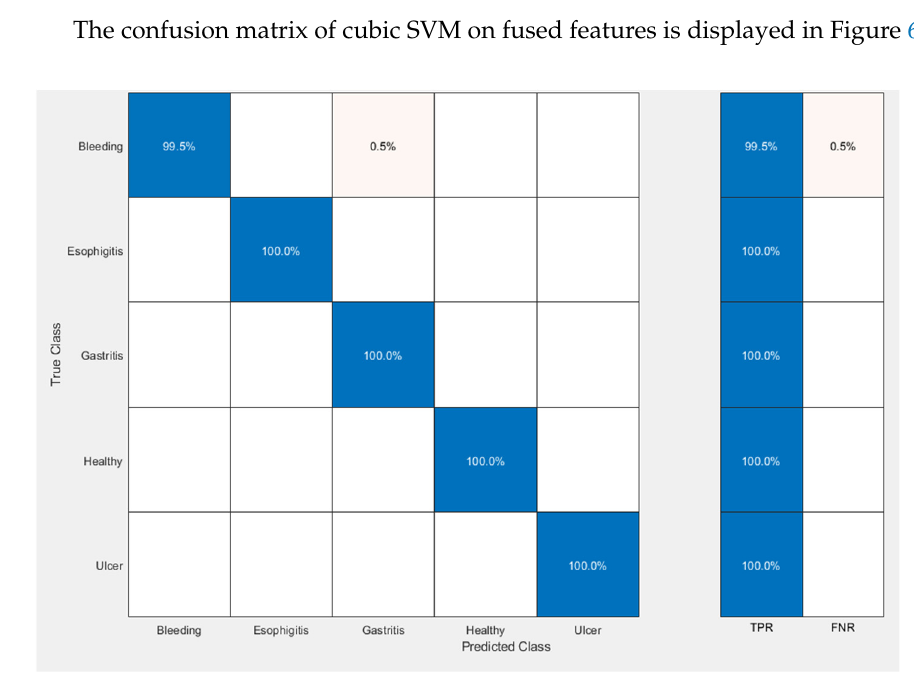
Figure 7. Confusion matrix (false discovery rates) of cubic SVM using fused features.